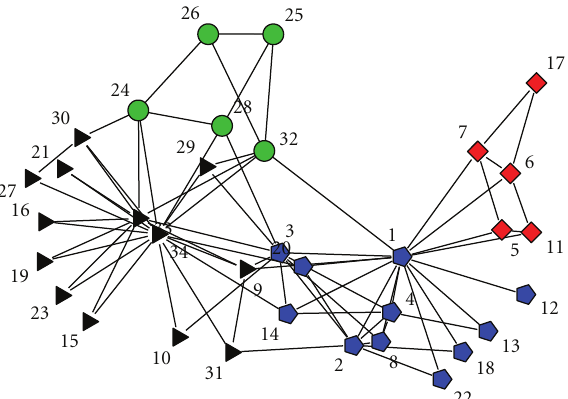
Figure 4: Zachary’s karate club network. Di ff erent shapes show the modules. M 1 : pentagon, M 2 : square, M 3 : triangle, M 4 : circle.